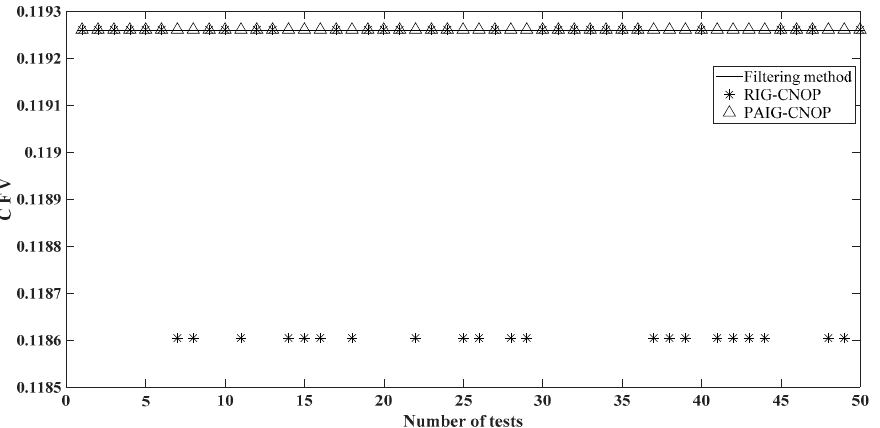
Figure 5. The distribution of the MCFVs corresponding to the CNOPs generated by the different methods at point C 1 , T = 400 .